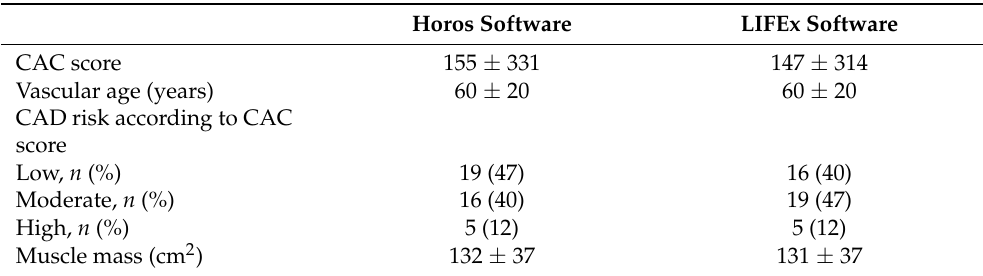
Table 2. Imaging findings in the overall patient population according to Horos and LIFEx